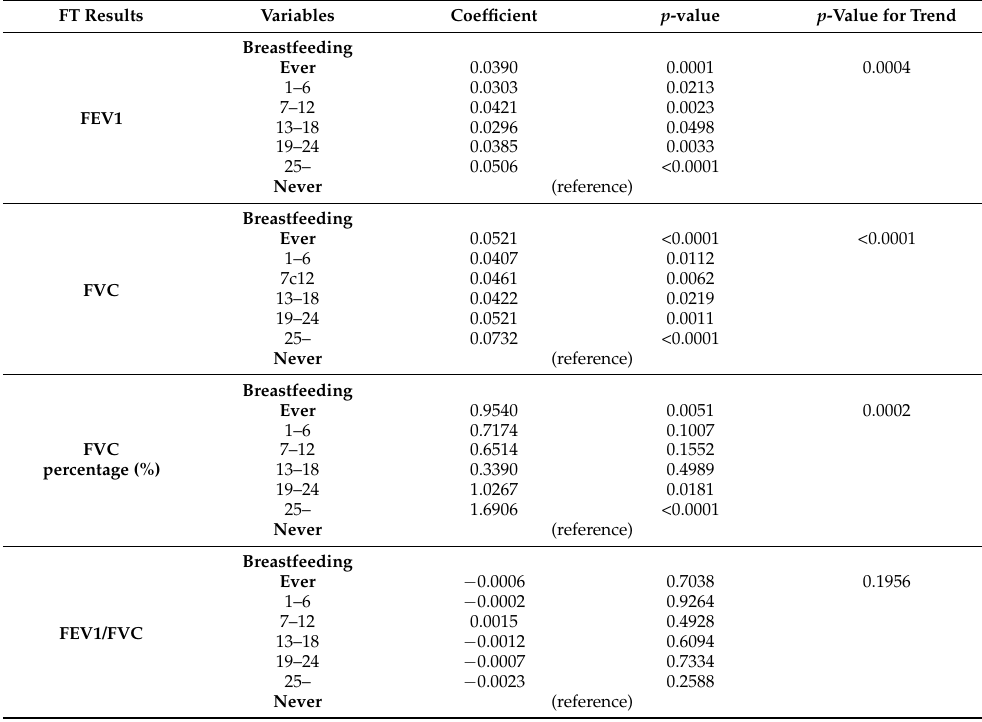
Table 3. Coefficients of pulmonary function test results according to breastfeeding or duration of